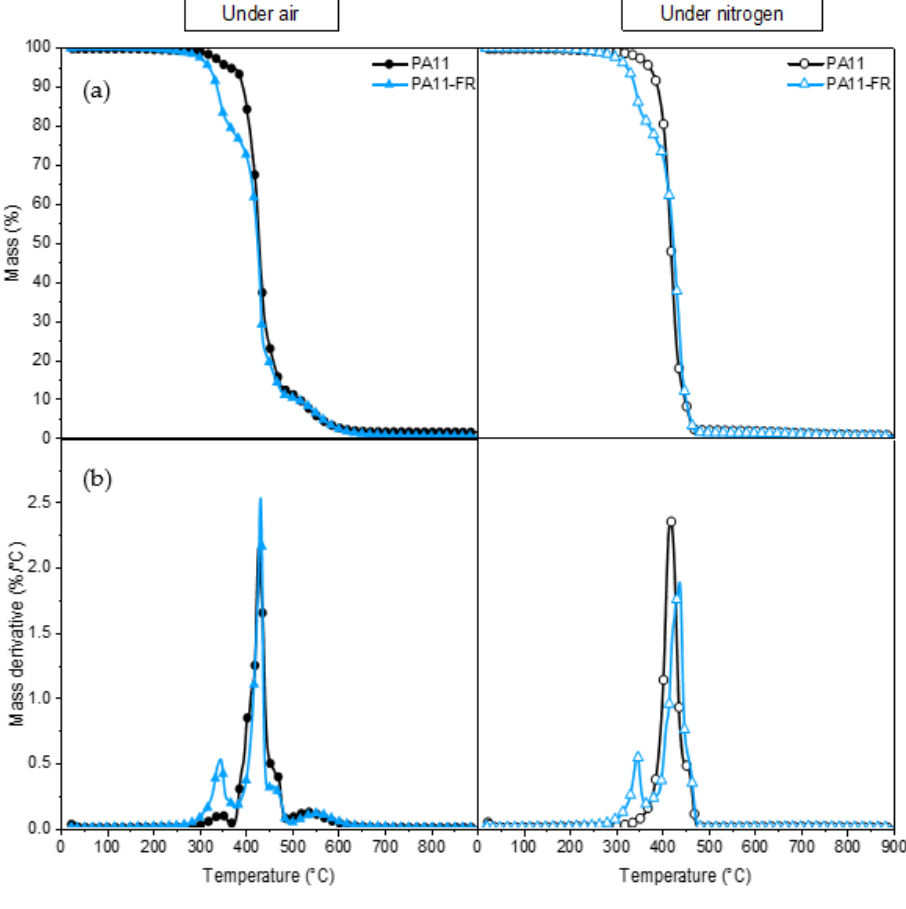
Figure 4. ( a ) TG and ( b ) DTG curves of PA11 and PA11-FR under air atmosphere and nitrogen at- mosphere.